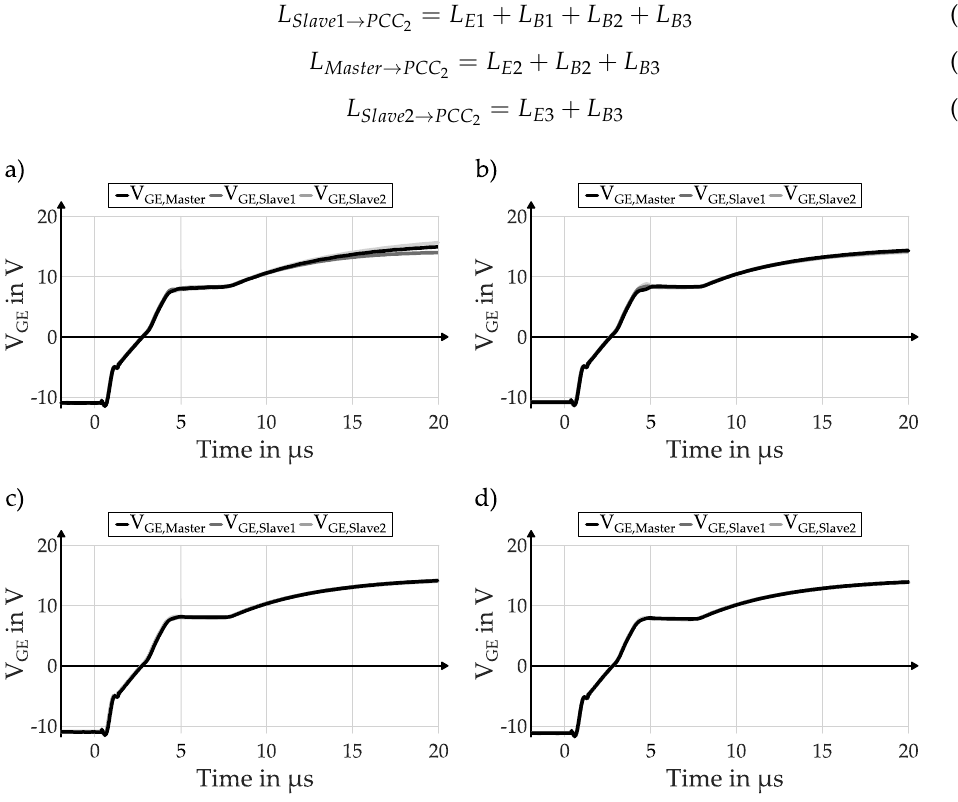
Figure 13. Experimental results of the gate-emitter voltage ( V GE ) of three PEBC modules of one PEBC module package with focus on the formation of the Miller plateau during switch-on operation of IGBTs for the investigated interconnection designs ( a – d ) as presented in Figure 12.